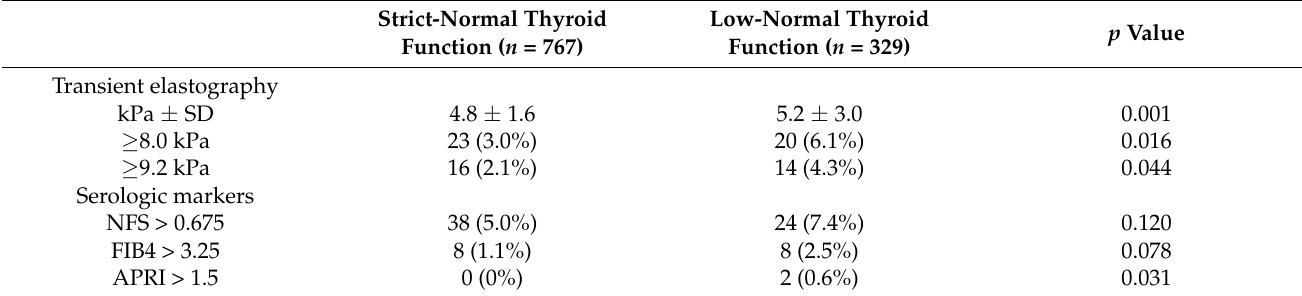
Table 2. Association between liver fibrosis according to thyroid function.